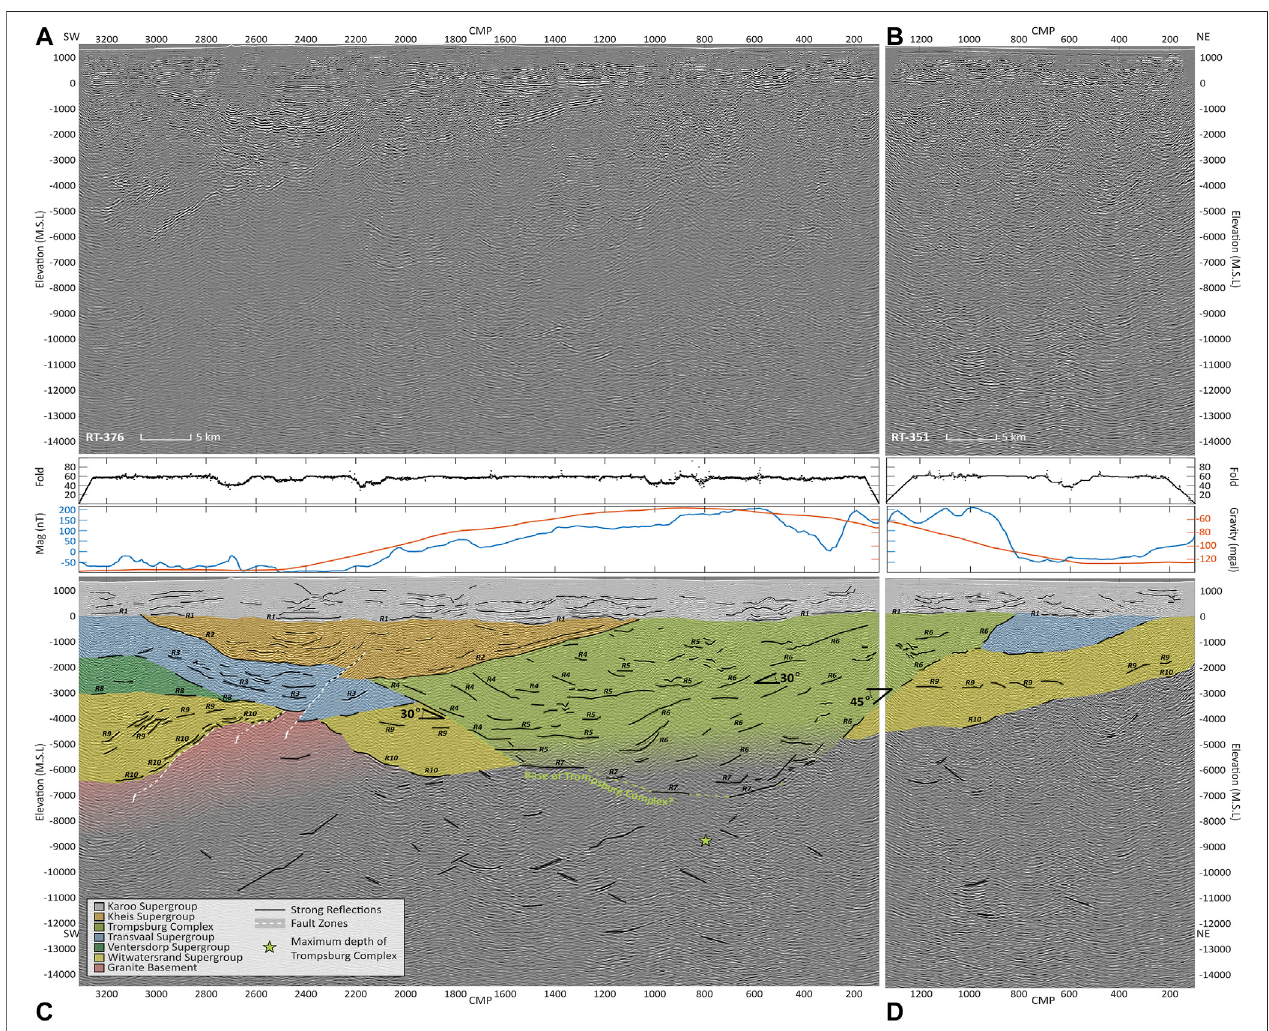
FIGURE6| Uninterpretedmigratedsectionsofpro fi lesP1(RT-376; A )andP2(RT-351; B )aswellasfoldplots,potential fi eldplots,andinterpretedsections (C,D) . Potential fi eld data were obtained by sampling the relevant maps displayed in Figure 1 along the seismic pro fi les. Interpreted sections comprise black lines denoting identi fi ed re fl ections, faults in dotted white lines, and stratigraphic units in colour. Identi fi ed re fl ectors are labelled as cited in the text.